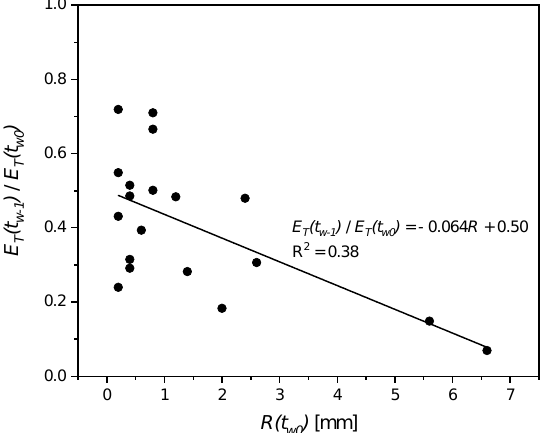
Figure 11. Reduction of E T in response to canopy humidification due to rain in the first half-hour of wetting phases ( R ( t w 0 ) ), described with ratio of E T during pre-wetting phase ( E T ( t w − 1 ) ) and the first half-hour of wetting phase ( E T ( t w 0 ) ). Only E T ( tw − 1 ) / E T ( tw 0 ) < 1 were used for the